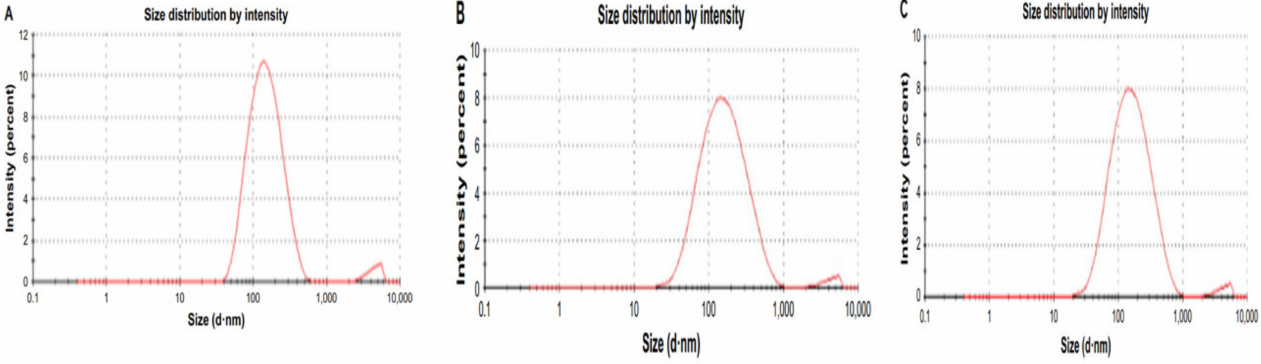
Figure 9. Size of the synthesized ZnO NPs nanoparticle and its distribution ( A ) 0.1 M ( B ) 0.05 M and ( C ) 0.01 M. Hy- drodynamic size of the synthesized nanoparticles was analyzed using the Zeta sizer (ZS) analytical instrument (Malvern Nano ZS90), and the results were obtained using ZS290 nano software coupled with the device. Adapted from Umar et al. (2019)